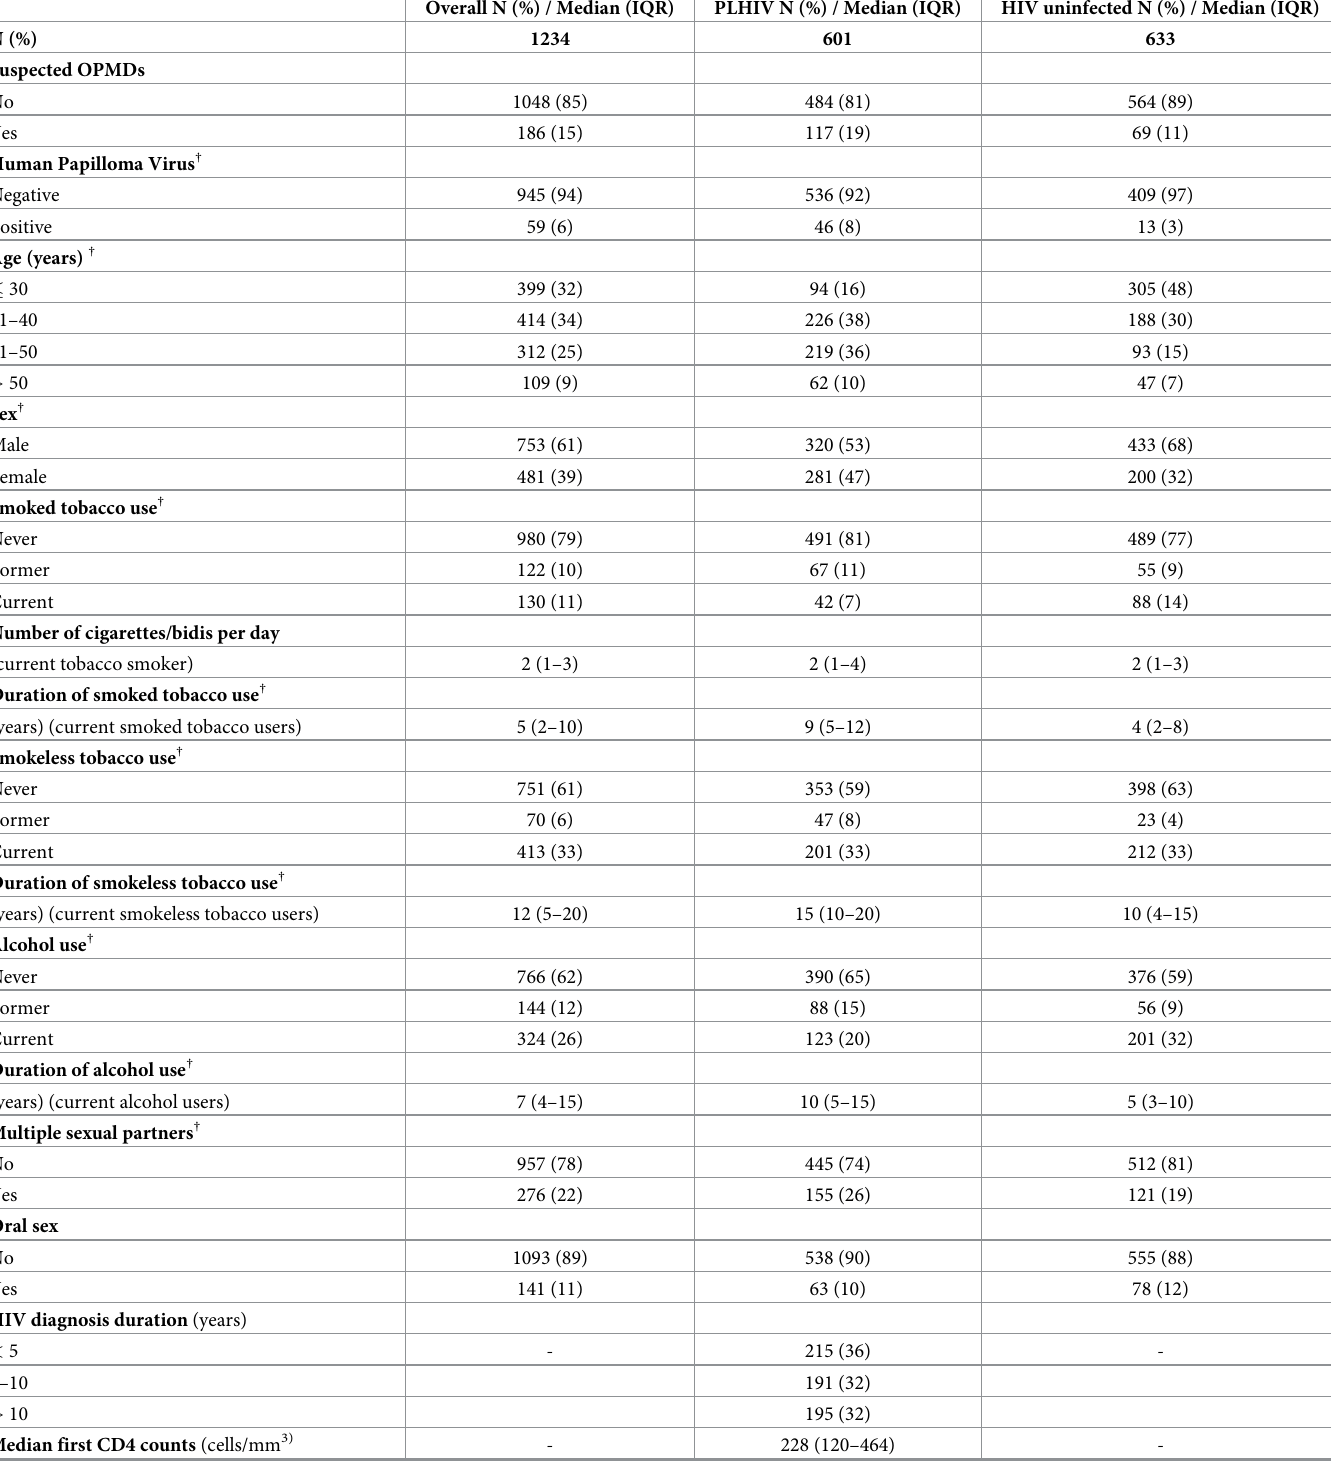
Table 1. Demographic and clinical characteristics of participants recruited in an mHealth-based oral cancer screening study in Pune,